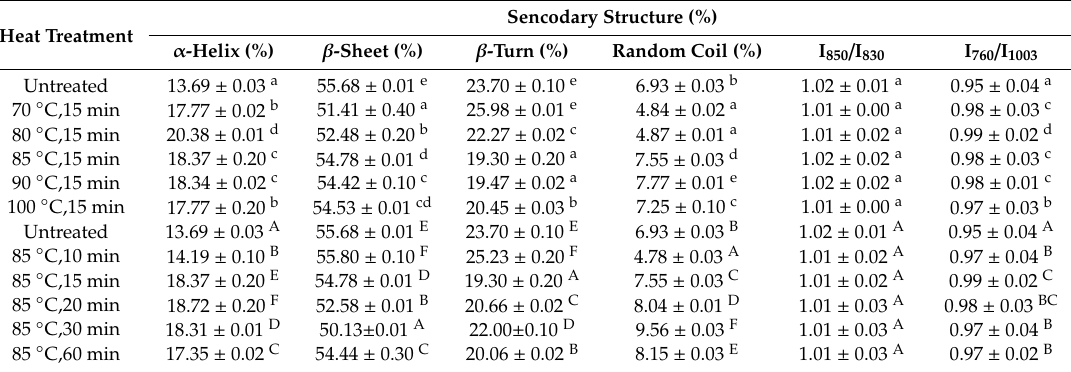
Table 1. Contents of the secondary structure prediction by Amide I bands and Fermi resonance ratio I 850 / I 830 and the number of tyrosine residues that are exposed / buried in heated SPI. Heat Treatment